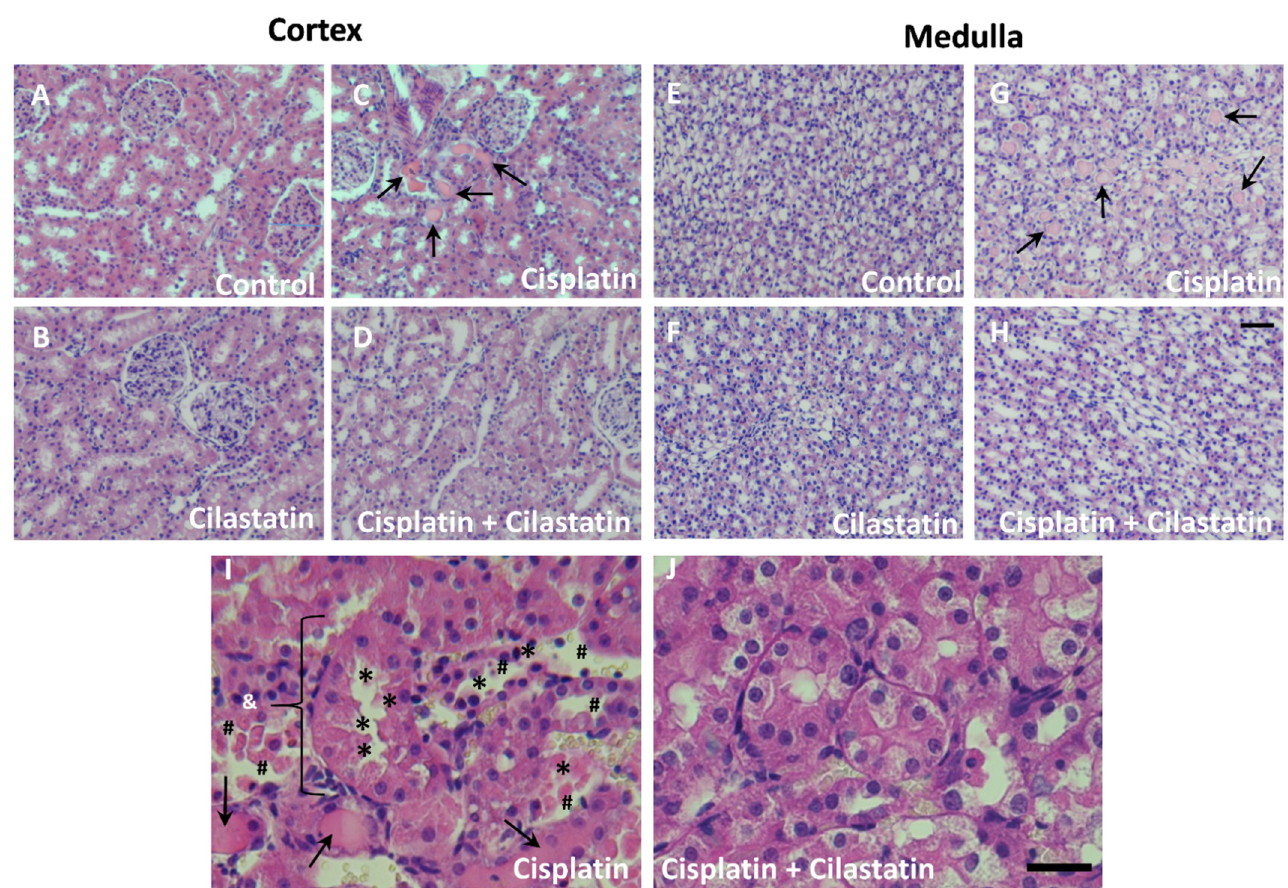
Figure 1. Histopathological analysis of hematoxylin/eosin-stained renal sections shows cilastatin protection against cisplatin-induced damage. Images are shown at 20× magnification for ( A ) control cortex; ( B ) cilastatin cortex; ( C ) cisplatin cortex; ( D ) cisplatin + cilastatin cortex; ( E ) control medulla; ( F ) cilastatin medulla; ( G ) cisplatin medulla; and ( H ) cisplatin + cilastatin medulla. Scale bar from A to H represents 100 µm. Detailed images of renal tubules at 60× magnification are displayed for ( I ) cisplatin and ( J ) cisplatin + cilastatin. Scale bar for I and J represents 25 µm. Renal damage indicators are represented: →: accumulation of protein casts in the renal tubules. & region: tubule swelling. *: loss of brush border membrane. #: cell debris detachment.